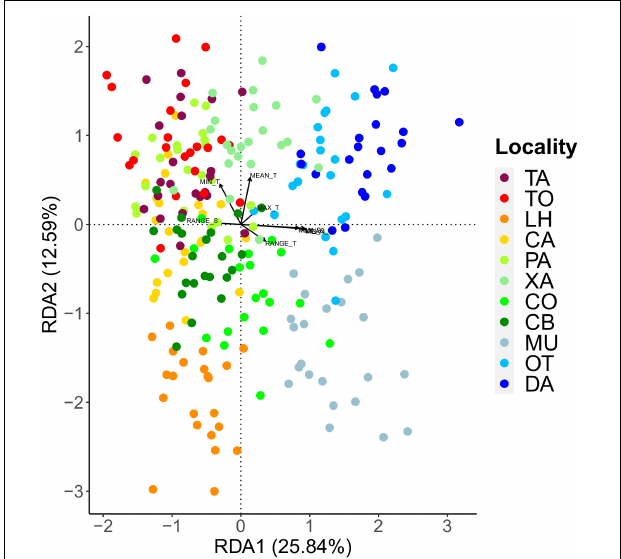
FIGURE 7 | Redundancy Analysis (RDA) performed with environmental data and SNP loci. Colored points represent individual sea urchins coded by locality. Vectors indicate the environmental predictors of the two first RDA